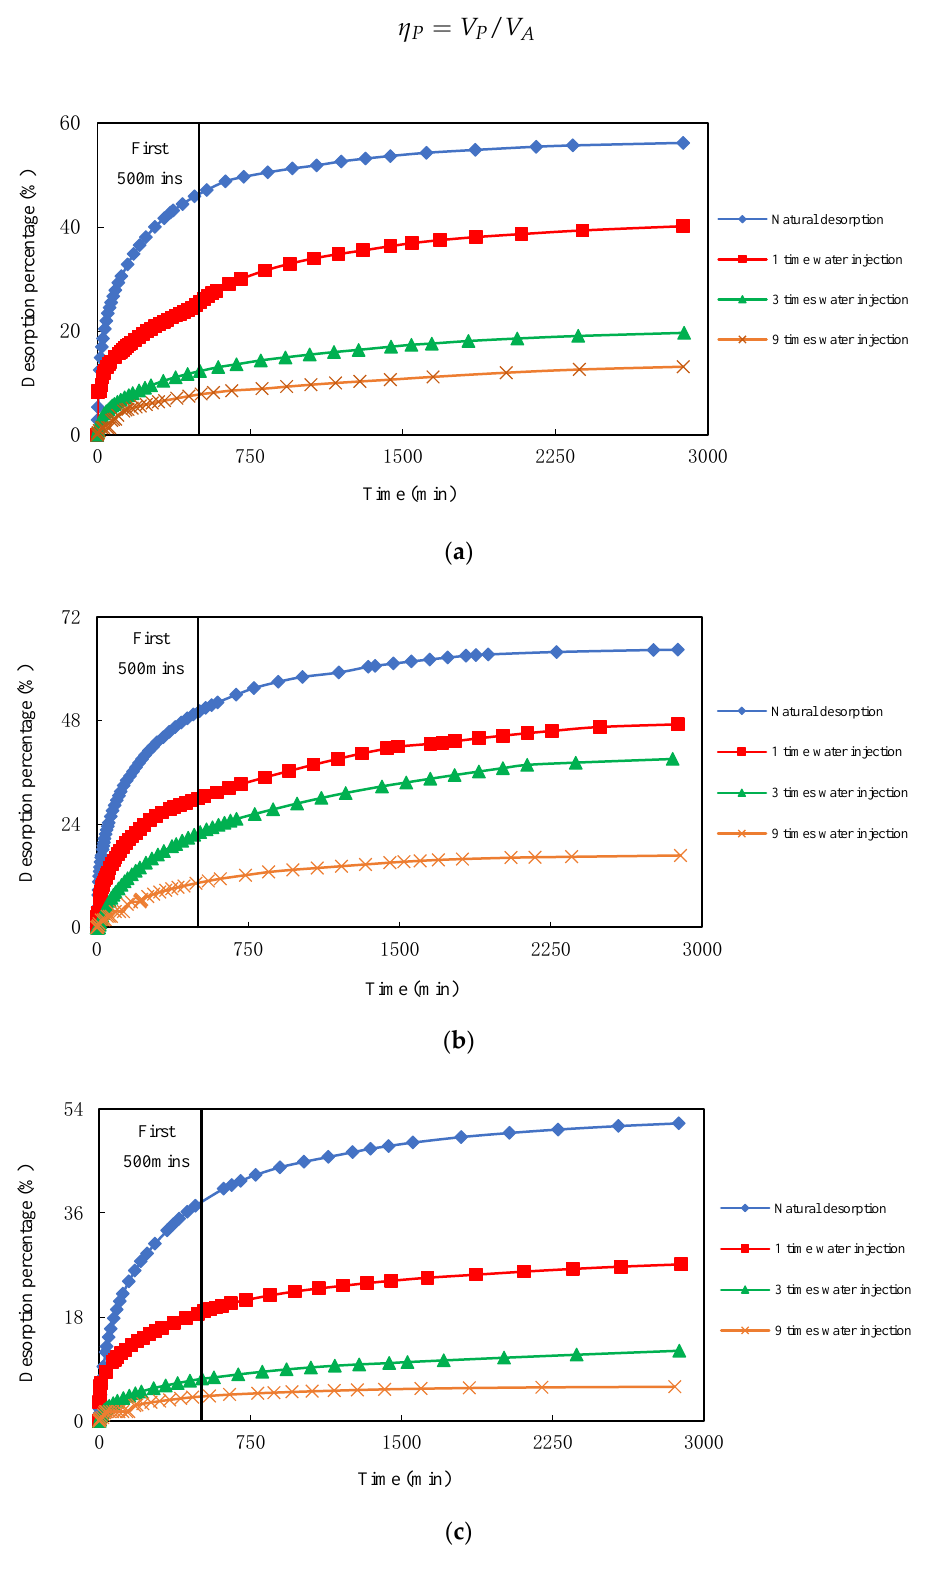
Figure 5. Desorption percentage as a function of time for coal samples at different water injection pressures. ( a ) Coal Sample 1-1; ( b ) Coal Sample 1-2; ( c ) Coal Sample 2-1.